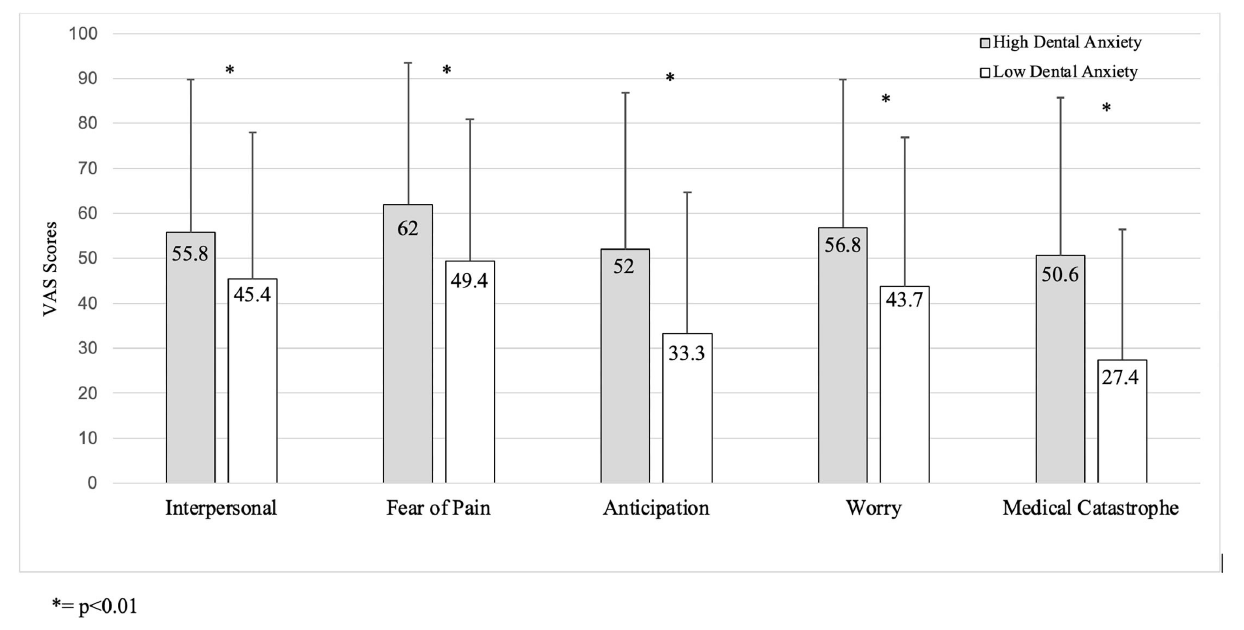
those for the Test-Retest Phase ( N = 139), presented